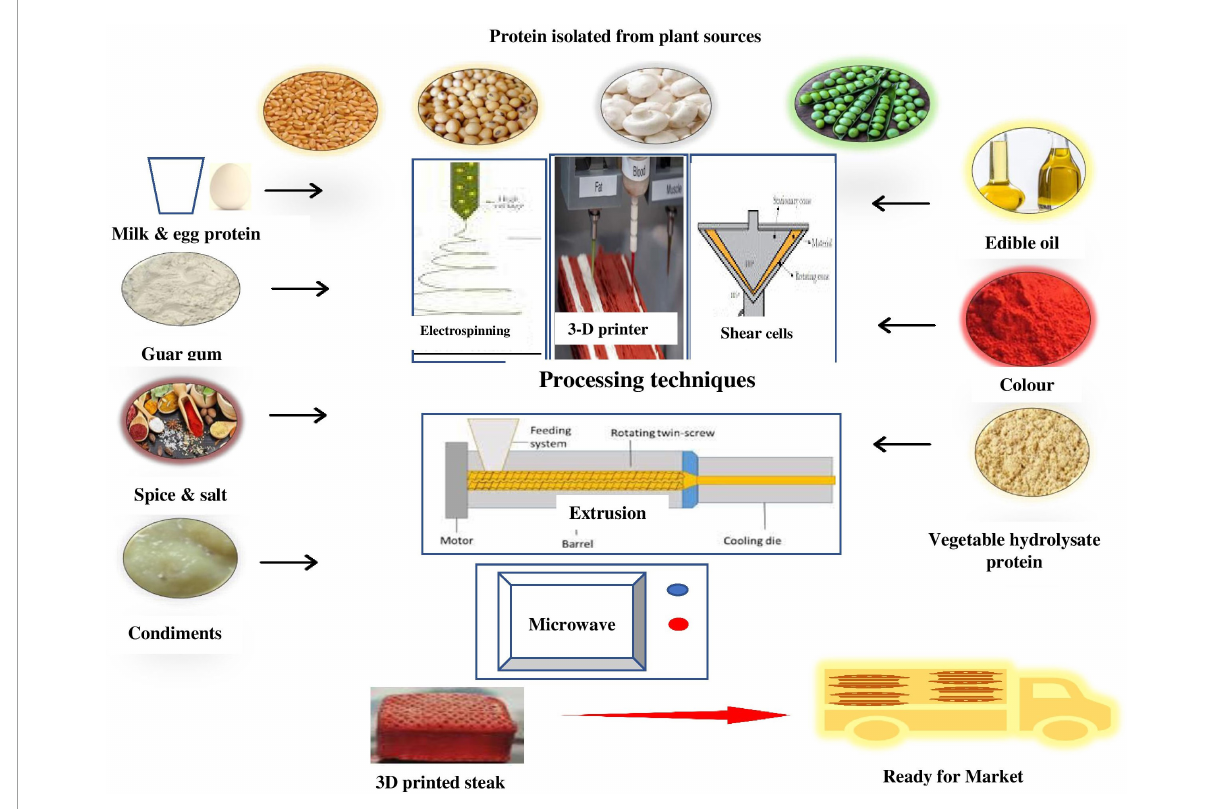
FIGURE3 Various aspects of improving the functionality of plant proteins through the development of meat analogs.